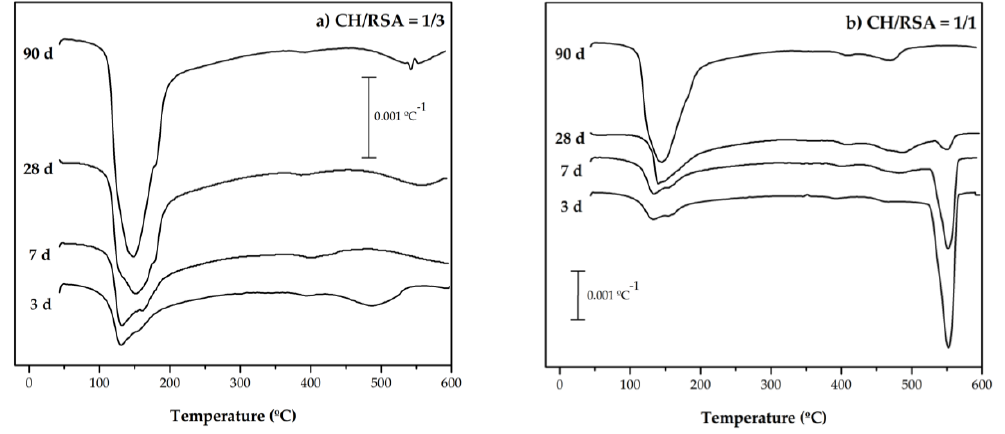
Figure 9. DTG curves for pastes CH/RSA: ( a ) 1/3 paste; ( b ) 1/1 Figure-9. DTG curves for pastes CH/RSA: ( a ) 1/3 paste; ( b ) 1/1 paste.